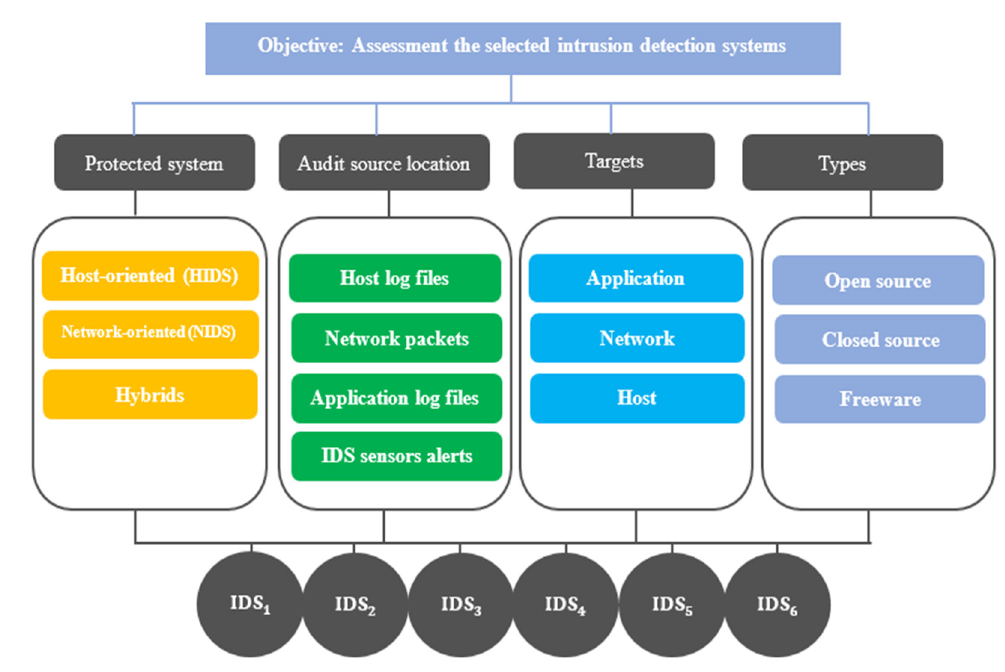
Figure 5. The hierarchy structure of the problem. Table 5. Verbal evaluations of the main criteria by each expert and the aggregated main criteria weights.